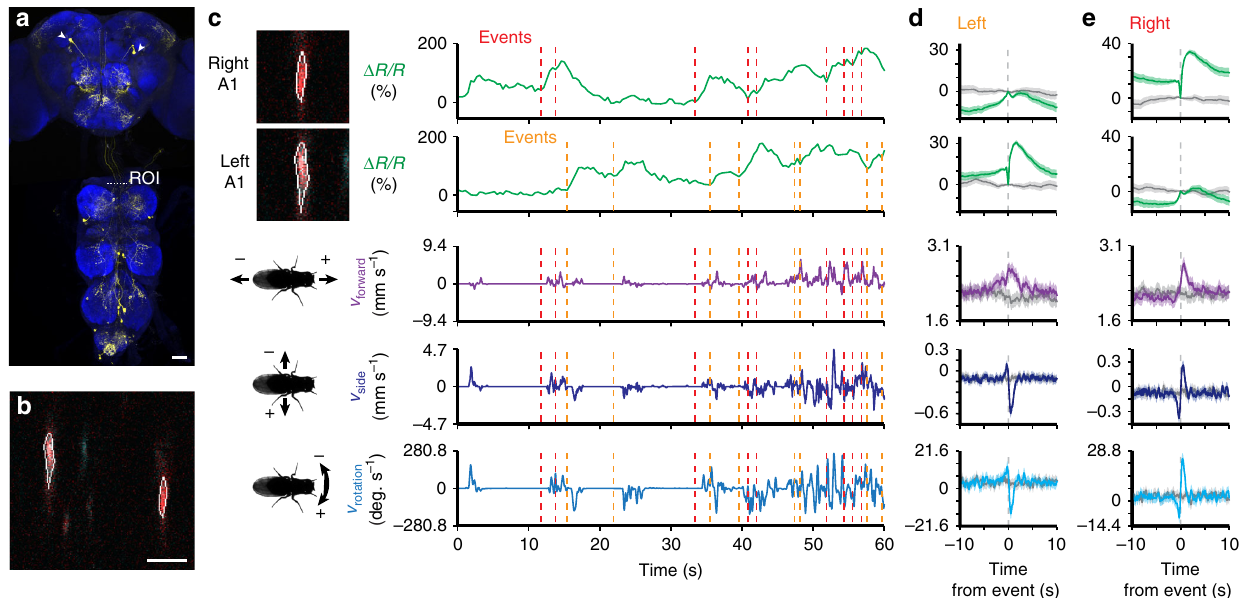
Fig. 5 Neural activity of A1 neurons in the thoracic cervical connective during behavior. a Confocal image of DNa01-Gal4 driver line expression in the brain and VNC. Scale bar is 40 µ m. Neuronal GFP (yellow) and neuropil (nc82, blue) are labeled. A dashed white line highlights the thoracic x – z plane imaged. b Coronal section of the thoracic cervical connective in an animal expressing GCaMP6s (cyan) and tdTomato (red) in A1 neurons ( A1 > GCaMP6s; tdTomato ). Scale bar is 5 µ m. c Separated ROIs (top-left) and associated fl uorescence signals from right and left A1 neurons (top-right). Corresponding forward, sideways, and rotational velocities of the fl y (bottom-right). Events are indicated as dashed red and orange lines for right and left A1 neuron events, respectively. d , e Summary of A1 neural activity and spherical treadmill rotations with respect to d left (1644 events) or e right (1651 events) A1 neuron fl uorescence events aligned to 0 s (dashed gray line). Control data in which events are time-shuf fl ed are overlaid in gray. Shown are the means (solid line) and bootstrapped 95% con fi dence intervals